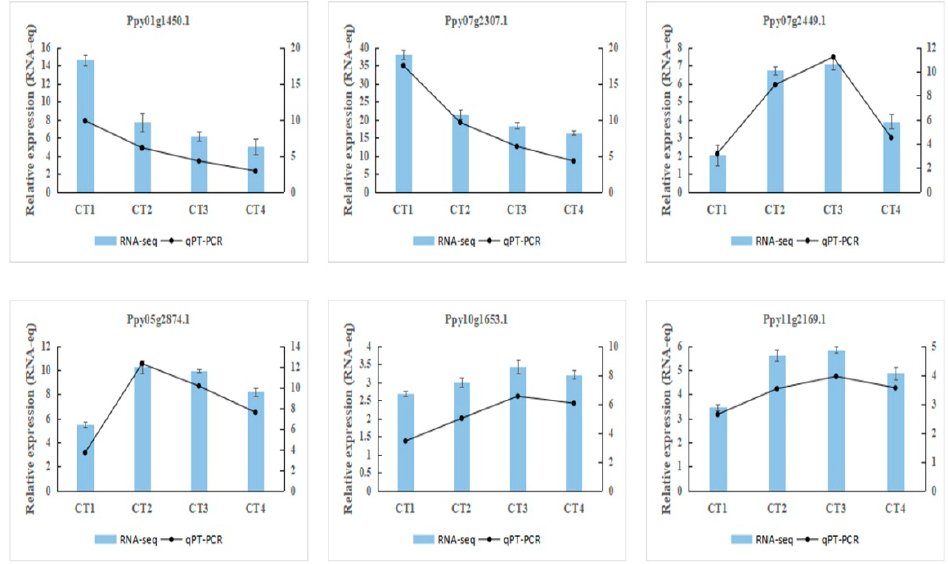
Figure 12. The accuracy of the RNA-seq date was verified by RT-qPCR.